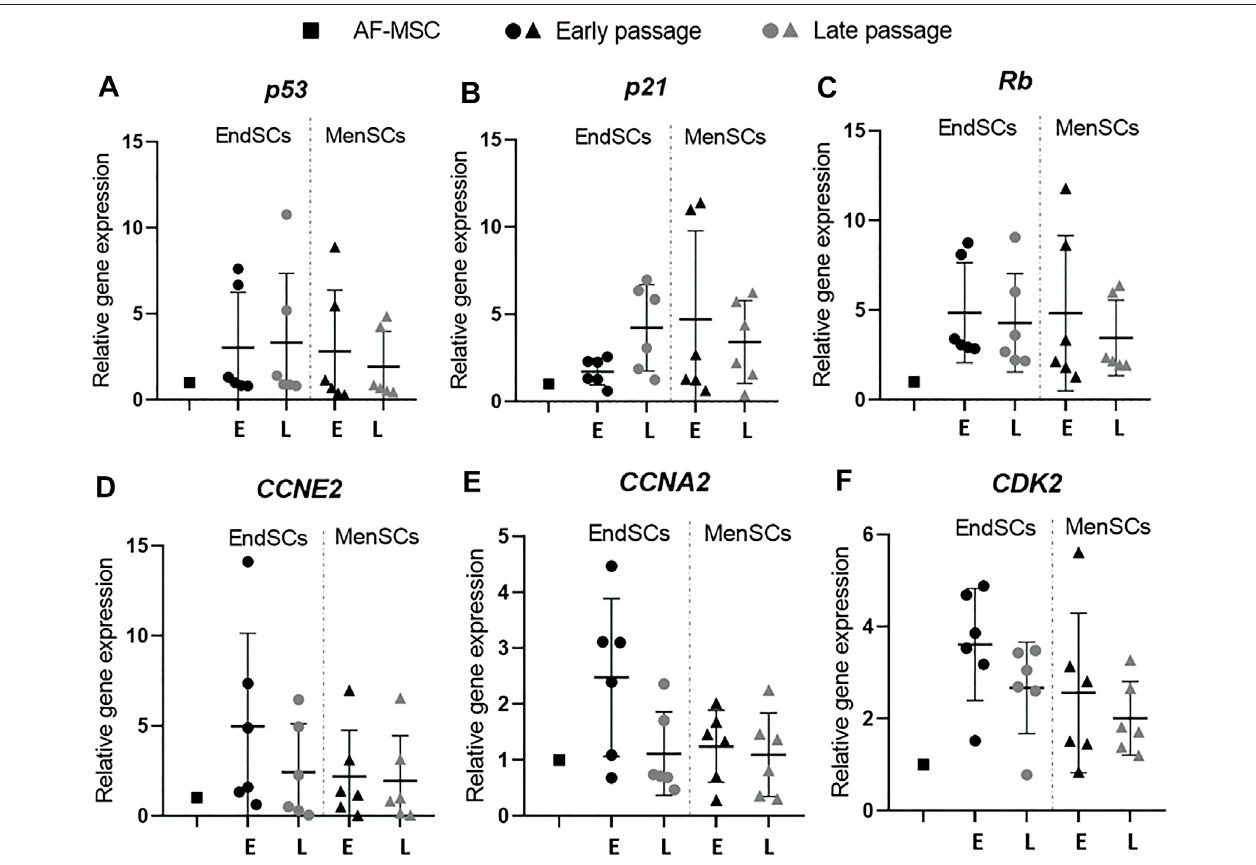
FIGURE 3 | Gene expression analysis of cell cycle regulation associated genes in EndSCs and MenSCs. (A – F) relative gene expression of p53, p21, Rb, CCNA2, CCNE2, CDK2 genes was detected in early and late passages and measured using RT-qPCR. E — early passage, L — late passage. Relative gene expression was calculated using ΔΔ Ct method. Data were normalized to GAPDH and presented as mean ± SD ( n (cid:2) 6). No statistically signi fi cant changes were detected between different passages and cell groups as evaluated by one-way ANOVA.